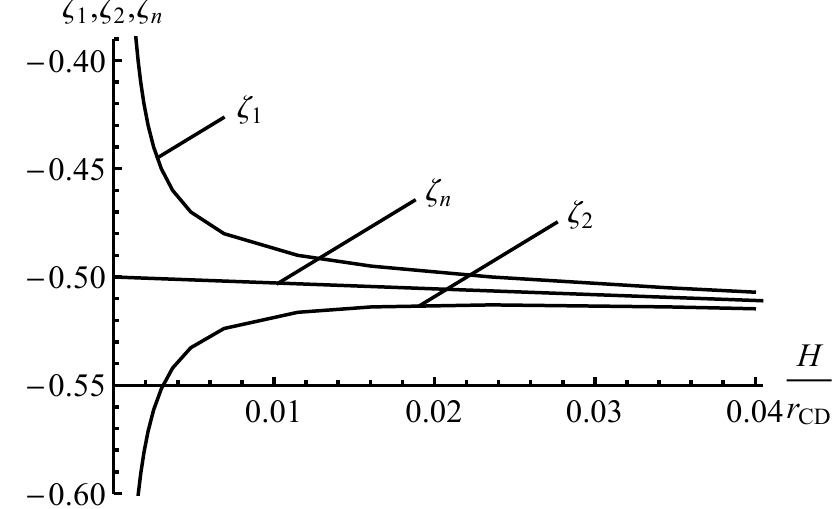
Figure 3. Variation of the locations of the elastic/plastic boundaries and the neutral line with H / r CD at the beginning of the